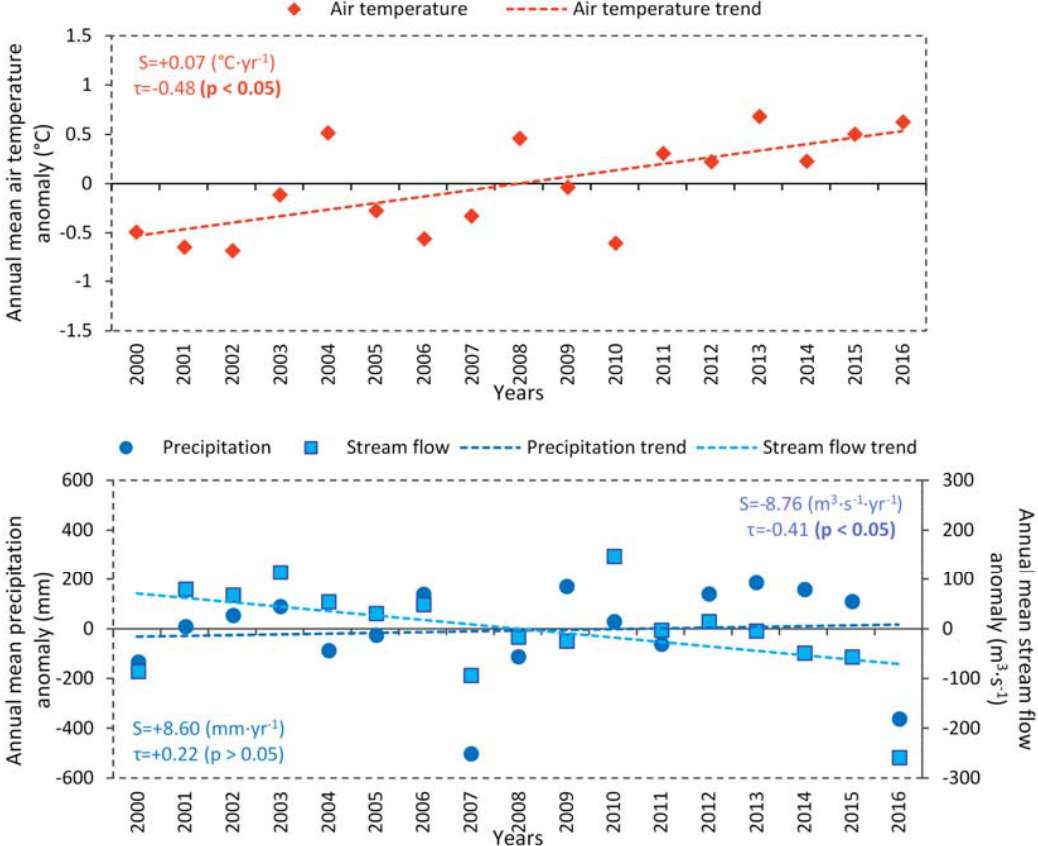
Figure 7. Annual mean anomalies for temperature ( top ), precipitation and stream flow ( bottom ) for in situ data between 2000 and 2016.